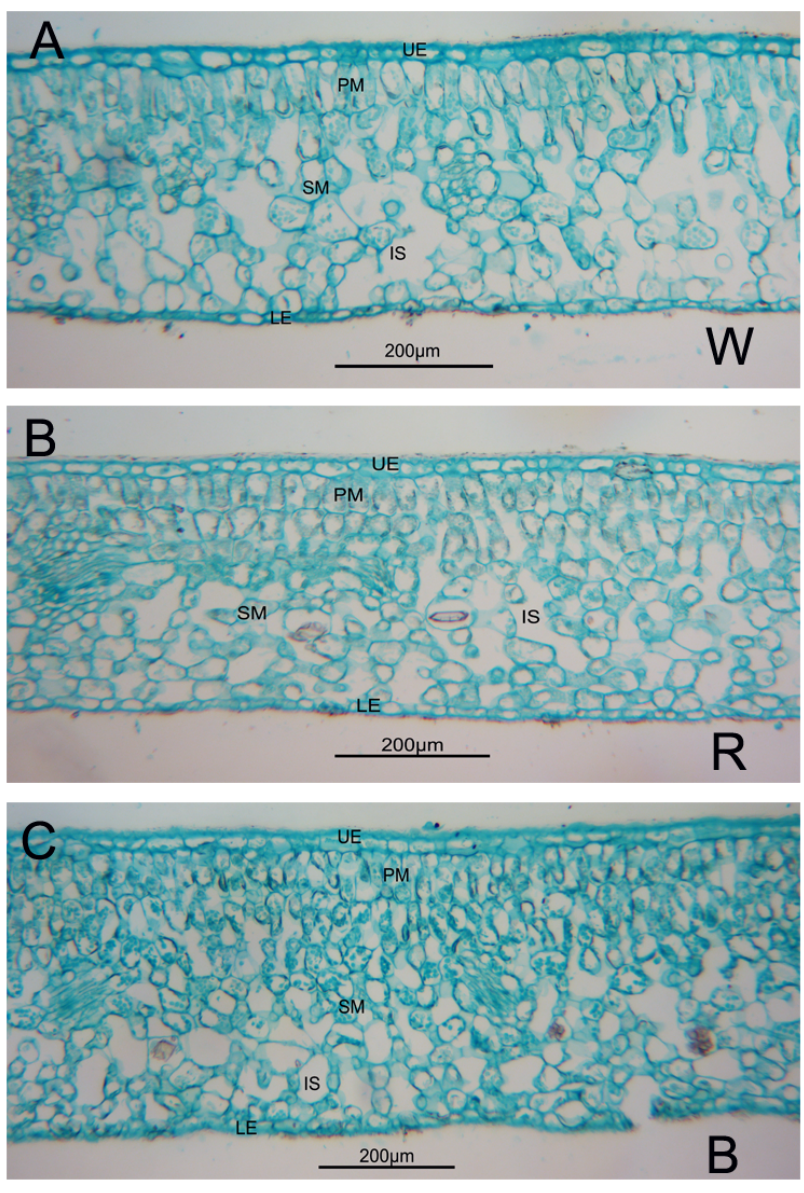
Figure 1. Influence of different light qualities on the leaf structure of C. oleifera. ( A ) The influence of white light on leaf structure in C. oleifera. ( B ) The influence of red light on leaf structure of C. oleifera. ( C ) The influence of blue light on leaf structure of C. oleifera. UE represents the upper epidermis; PM represents the palisade mesophyll; SM represents the spongy mesophyll; IS represents the intercellular spaces; and LE represents the lower epidermis. W, R, and B represent white, red, and blue light conditions, respectively. The bar is 200 μm.